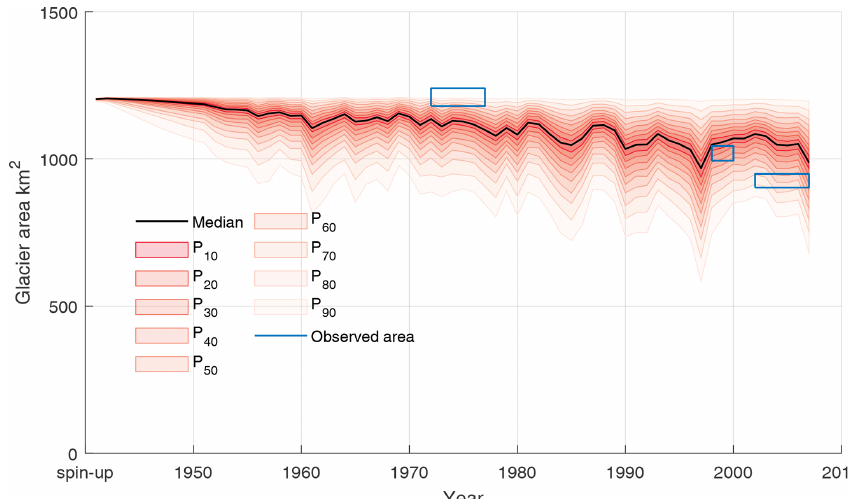
Figure 6. Simulated (top 0.5%, n = 751) catchment-wide glaciated area using parameters for the Ust. Kurgan station which is located at the outlet of the catchment. The Landsat-observed glaciated area (Kriegel et al., 2013) is shown in blue boxes, where the error on the time axis relates to the years when satellite imagery was used to calculate area. The Landsat-glaciated area uses satellite imagery from the 1970s (1972–1977), late 1990s (1998–2000) and mid-2000s (2002–2007). A simulated threshold glacier depth of 1mm is used to identify the presence of glacier ice. The figure shows the spread of the glaciated areas predicted by the model, but the simulations are not sorted by conditional probability values.